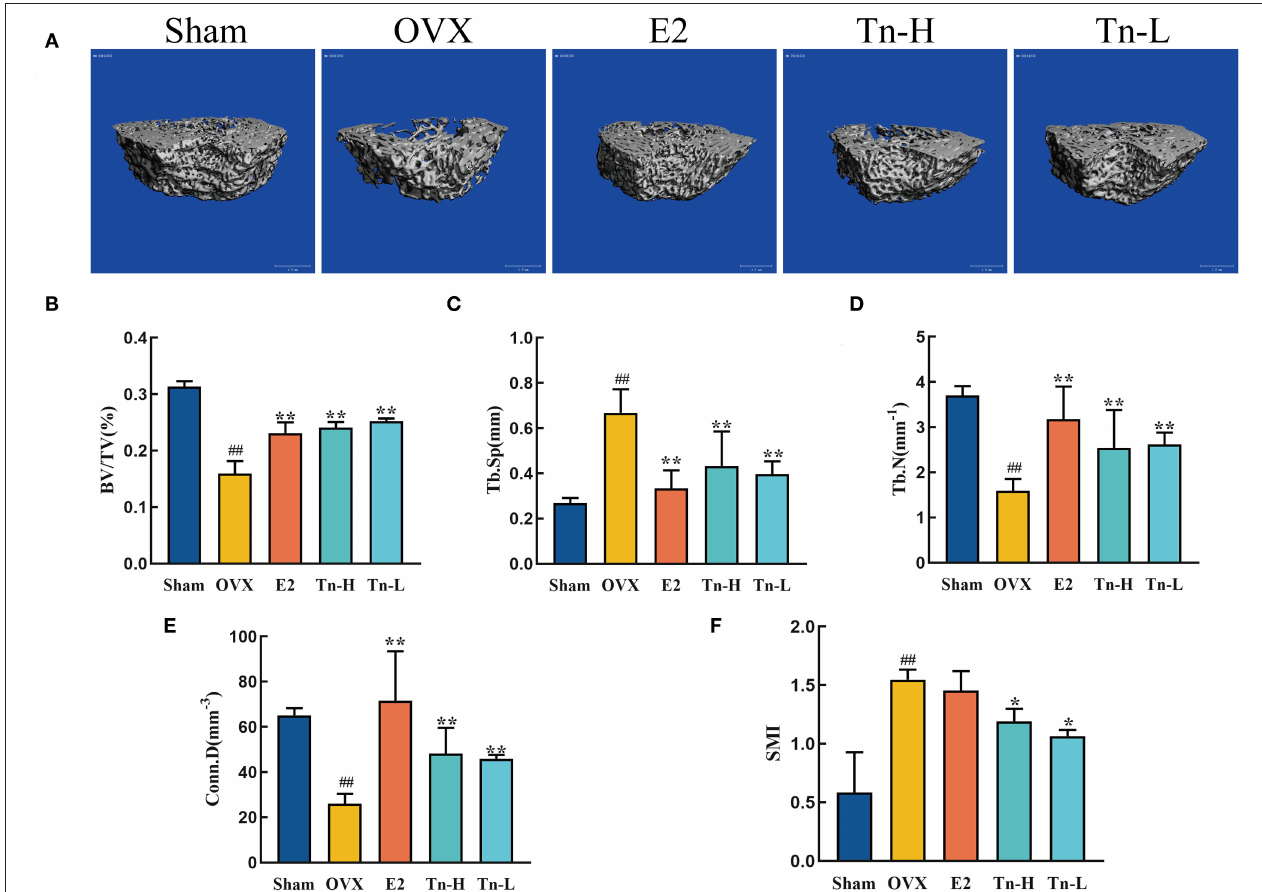
FIGURE 1 | Effect of THLs on the femoral microstructure of ovariectomized rats: (A) Transverse views of bone tissue microstructure. (B–F) Quantitative results of bone volume fraction (BV/TV), trabecular number (Tb.N), trabecular separation (Tb.Sp), cortical density (Conn.D), and structural model index (SMI) (Tn-H, high-dose THLs group; Tn-L, low -dose THLs group). Data are presented as the mean ± SD ( n = 8 per group). Multiple comparisons were performed using one-way ANOVA. # p < 0.05 vs. Sham group; ## p < 0.01 vs. Sham group; * p < 0.05 vs. OVX group; ** p < 0.01 vs. OVX